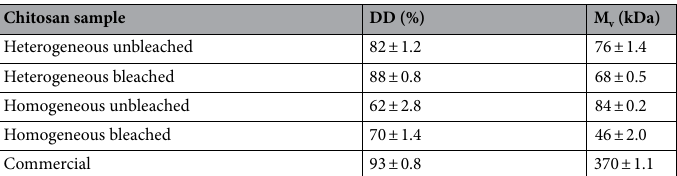
Table 1. Deacetylation degree (DD) and viscosity-average molecular weight (M v ) of heterogeneous and homogeneous chitosan samples obtained from both unbleached and bleached chitin, and the commercial sample. Data are expressed as mean ± standard